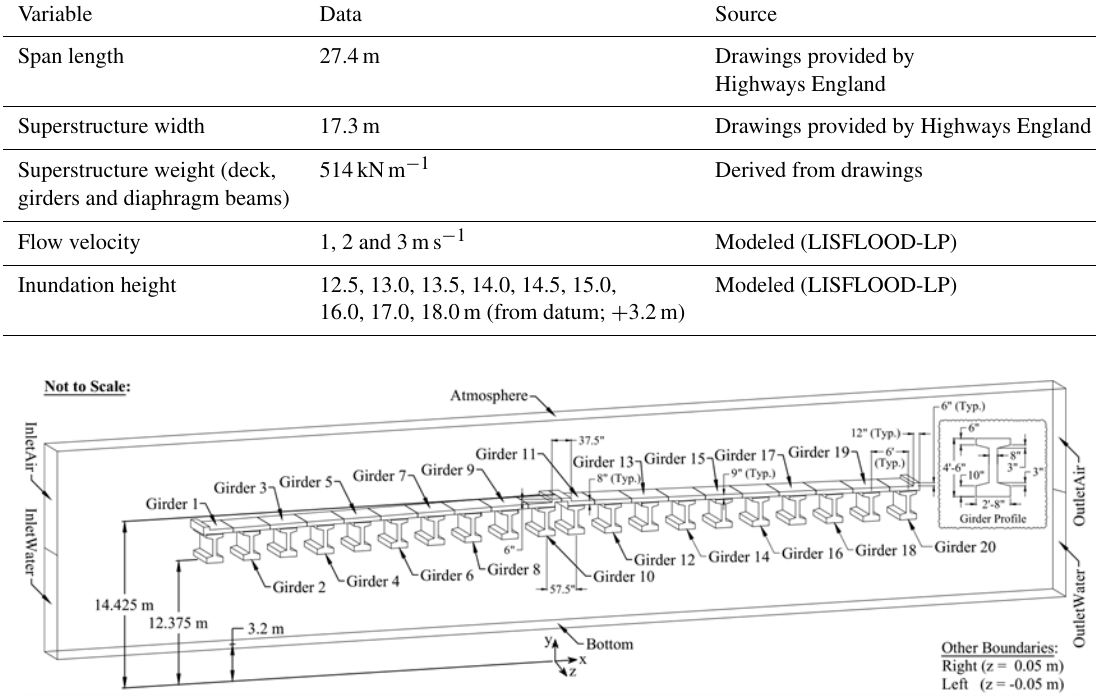
Table 2. Input data of this study for the exemplary CFD analysis of the M6 bridge (Carlisle, UK).